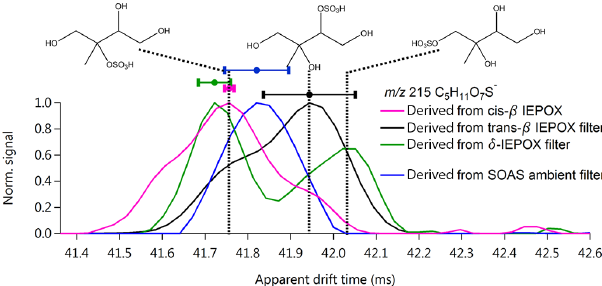
Figure 4. Ion mobility spectra of HSE (C 5 H 11 O 7 S − ) in four dif- ferent aerosol filter samples. Dashed vertical lines indicate the three different IMS peaks/isomers observed in different combinations in each sample. All spectra have been normalized to facilitate qualita- tive comparison. The bars on the top denote the uncertainty in the drift time dimension for each peak and were determined from the standard error of the mean of a mobility calibration compound from its average drift